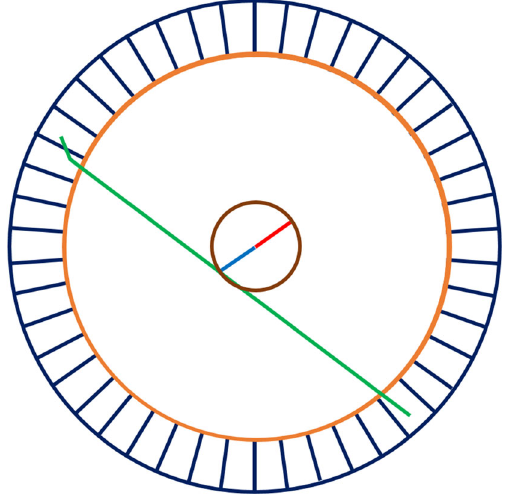
Fig. 6 Illustration of a typical γγ → e + e − event. A positron is